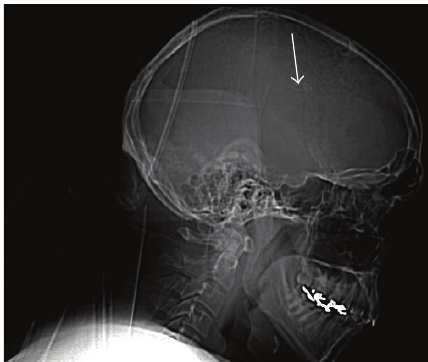
Figure 5: Lateral radiograph of the skull demonstrating a focus of calcification in the frontoparietal region (arrow).